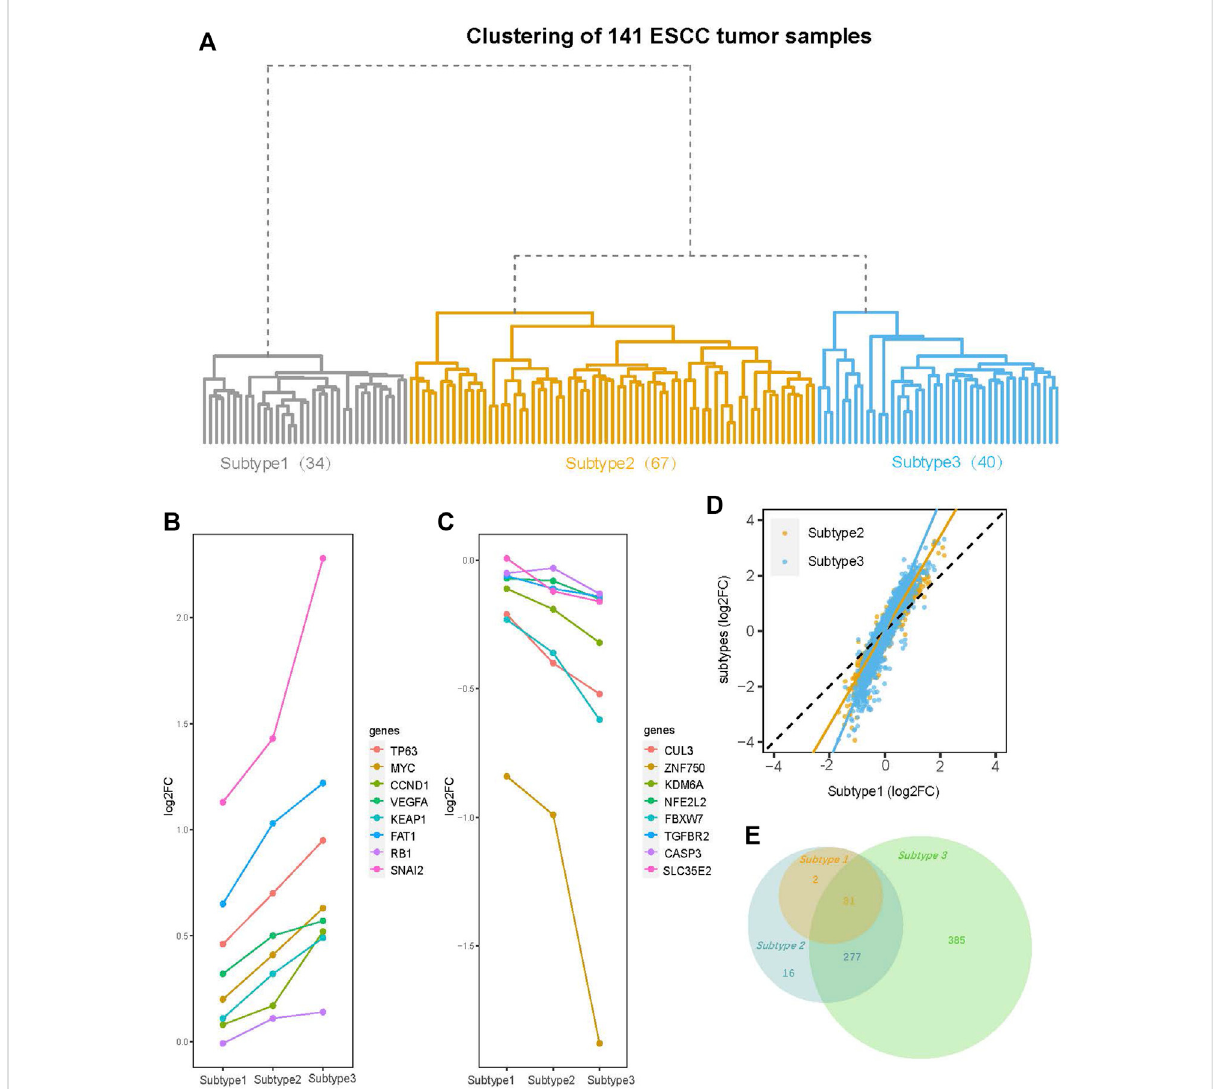
FIGURE 2 Clustering tree of the 141 ESCC tumor samples and an overview of differential gene expression (DGE) analysis. (A) The hierarchical clustering tree diagram of 141 ESCC tumor samples constructed by the gene expression pro fi le. The 141 ESCC tumor samples were clustered into three subtypes(Subtype1,Subtype 2, andSubtype 3),with samplesizes of34,67,and 40for Subtype 1to Subtype 3,respectively. (B) The log 2 fold-change (log 2 FC) of the genes (TP63, MYC, CCND1, VEGFA, KEAP1, FAT1, RB1, and SNAI2) with ampli fi cation mutations on ESCC genome are increased graduallyfromSubtype1toSubtype3. (C) Thelog 2 FCofESCCgenomicinsertionordeletionmutantgenes(CUL3,ZNF750,KDM6A,NFE2L2,FBXW7, TGFBR2CASP3, andSLC35E2)decreasedgraduallyfromSubtype 1toSubtype 3. (D) Comparisonoflog 2 FCofall the13515genesbetweensubtypes. Among three subtypes, the degree of change in the expression levels of most genes is: Subtype 3 > Subtype 2 > Subtype 1. (E) Venn diagram shows overlaps of differential expressiongenes (DEGs) (FDR < 0.05, |log 2 FC| > 1)among three subtypes. The numbers of DEGs include both up- and down- regulated genes in tumor tissue compared to normal